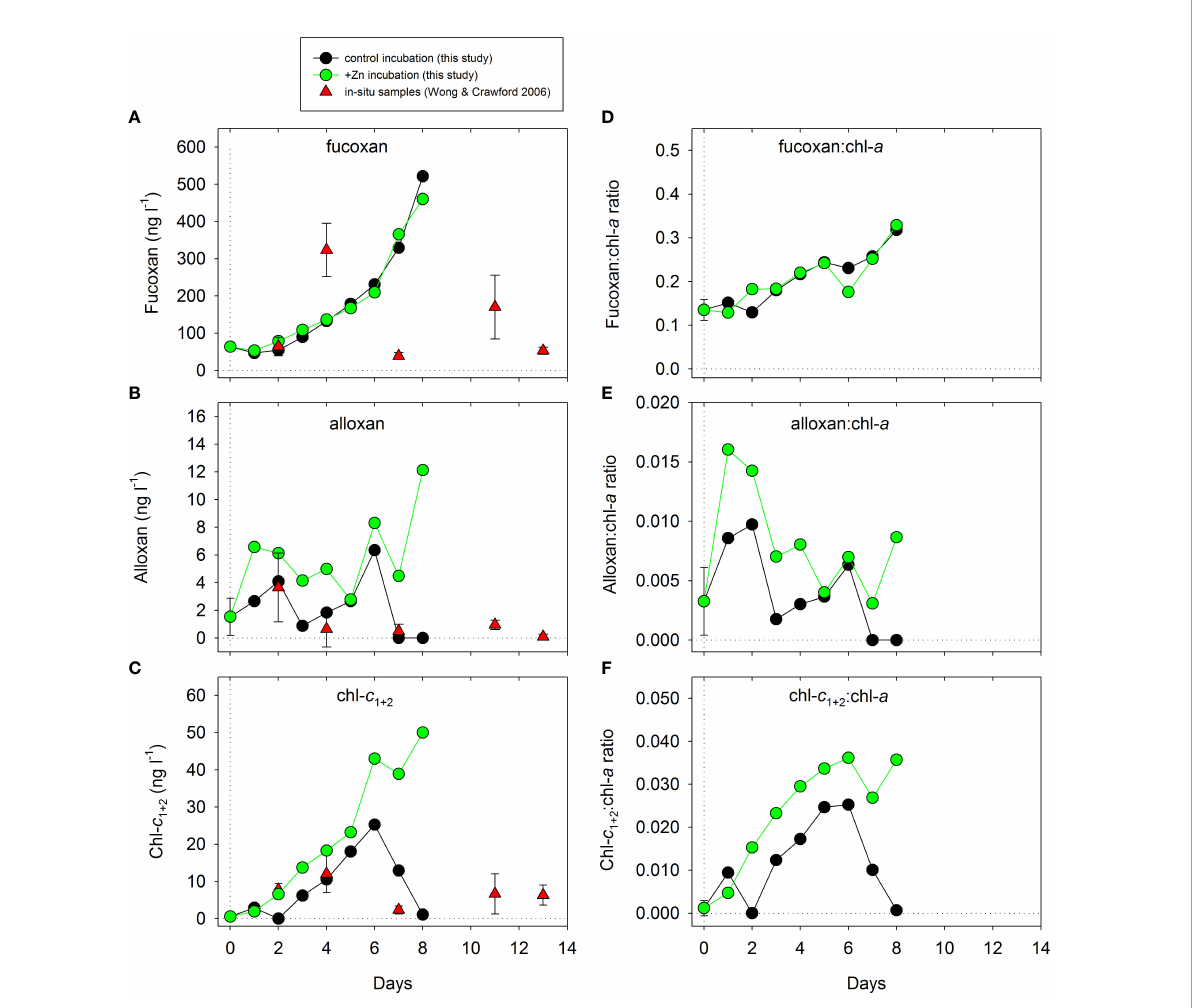
FIGURE 3 Comparison of concentrations of (A) fucoxan, (B) alloxan, and (C) chl- c 1+2 (from Figure 2, now on a linear scale) over time between the present incubation study and the open water study of Wong and Crawford (2006). Panels (D-F) show the same three pigments normalized to changes in total chl- a in the incubations. Alloxan and chl- c 1+2 showed signi fi cant differences between control and +Zn treatment (see Figure 2 and Table 2). Data from Wong and Crawford (2006) represent in situ concentrations averaged over the upper 35 m of the water column from samples taken outside a Fe-enriched patch of surface water at OSP in July 2002 (see Boyd et al.,